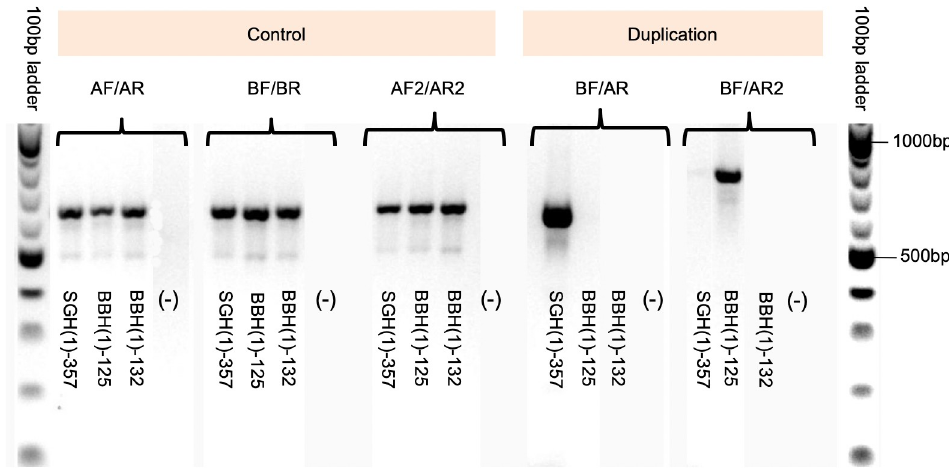
Fig 1. Ethiopian P . vivax samples contain both the Malagasy- and Cambodian-type duplications. AF/AR, BF/BR and AF2/AR2 are control primers where all samples indicated amplifications except the negative control sample. Sample SGH(1)-357produced a band of ~650bp with BF/AR primers, indicative of a Malagasy PvDBP duplication. Sample BBH(1)-125produced a band of ~750bp with BF/AR2 primers, indicative of a Cambodian PvDBP duplication. Sample BBH(1)-132showed no amplification with both BF/AR and BF/AR2 primers, indicative of a single PvDBP region without any duplications. No bands were observed for DNA-negative control (-) in all amplifications.